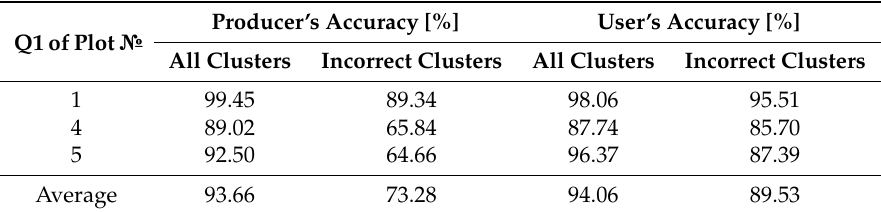
Table 3. Producer’s and user’s accuracies for 3D validation of tree segmentation. Both types of accuracies were calculated for all tree clusters of the plot quadrant and only for tree clusters with a volumetric error >